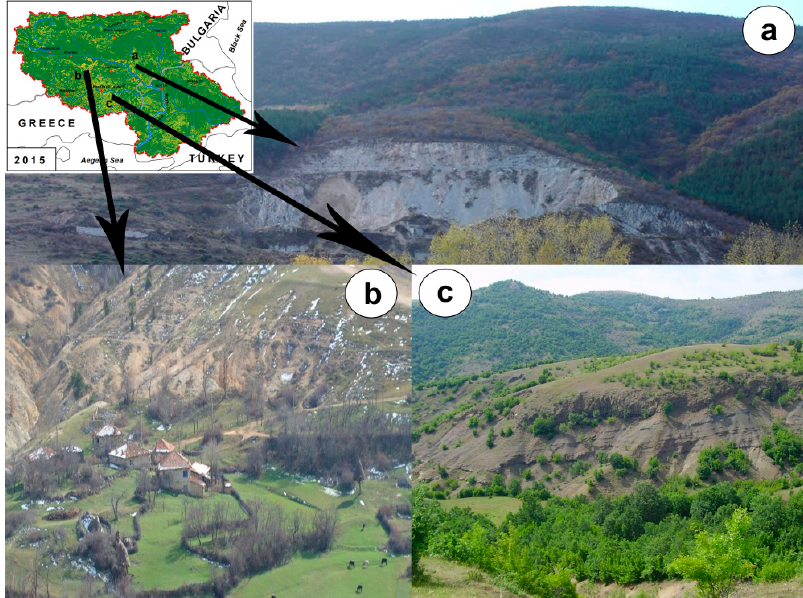
Figure 5. Severe soil erosion-prone areas in the Maritsa Basin, illustrating the region with ( a ) higher vegetation density is supposedly less prone; ( b ) sparse vegetation density is supposed more prone; ( c ) moderate vegetation density is proposed as moderately susceptible to soil erosion.